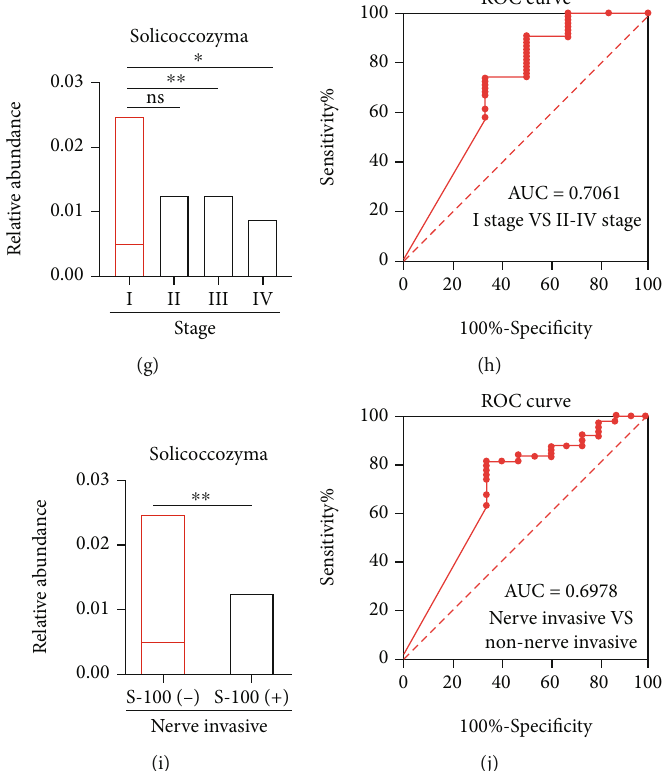
Figure 3: Fungal microbiome pro fi ling revealed the role of Solicoccozyma in the GC microenvironment. (a) A heatmap described the average abundance of the top 50 gastric fungi at the genus level; (b) a cluster heatmap indicated the di ff erentially enriched gastric fungal microbiomes between the two groups; (c) the 13 fungal microbiotas that had higher abundances and were di ff erentially enriched in the tumor group by comparison to the normal group based on the Mann – Whitney U test; (d) LEfSe identi fi ed the taxa with the greatest di ff erences in abundance between the tumor and normal group, the taxa with a signi fi cant LDA threshold value of > 2 and P value < 0.05 are shown (p: phylum, c: class, o: order, f: family, g: genus, s: species); (e) the distribution of Solicoccozyma account for a percentage of gastric fungi in the GC microenvironment; (f) a cluster heatmap showed the abundance of Solicoccozyma in the primary tumor and corresponding paired normal tissues from 61 GC patients, and GC patients with positive Solicoccozyma expression in tumor was described; (g) the abundance of Solicoccozyma in GC patients with stages I, II, III, and IV; (h) the ROC curves of Solicoccozyma provided an area under the receiver-operating characteristic curve (AUC) for the classi fi cation of the stage I and stage II-IV GC patients; (i) the abundance of Solicoccozyma in GC patients with nerve invasion and nonnerve invasion; (j) the AUC value of Solicoccozyma for the classi fi cation of the nerve invasive and nonnerve invasive GC